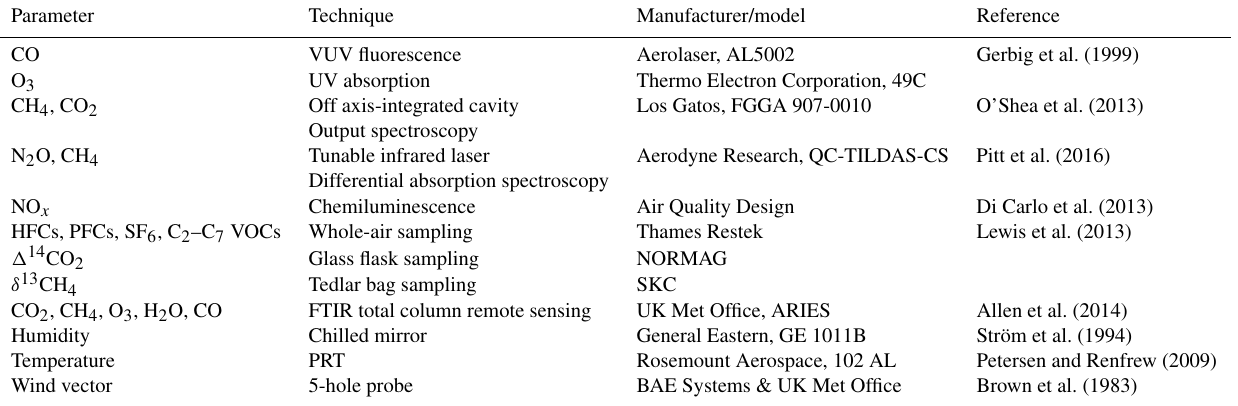
Table 5. Key instrumentation on board the FAAM aircraft for GAUGE-specific flights, including measurement principles and references to instrument characteristics (where available). VUV denotes vacuum ultraviolet (light); HFCs, PFCs, and VOCs denote hydrofluorocarbon, perfluorocarbons, and volatile organic compounds, respectively; and PRT denotes platinum resistance